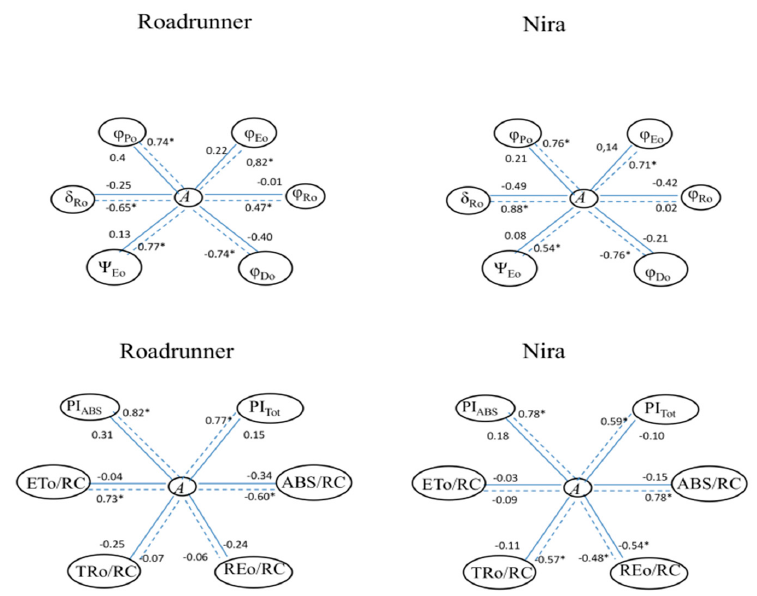
Figure 9. Pearson correlation coefficients ( r ) between prompt fluorescence parameters and CO 2 assimilation ( A ) (correlations significant at p < 0.05, n = 6). Relations between parameters marked by a solid line were calculated for plants in control conditions, and those marked by a dotted line were calculated for plants under 30% FWC.